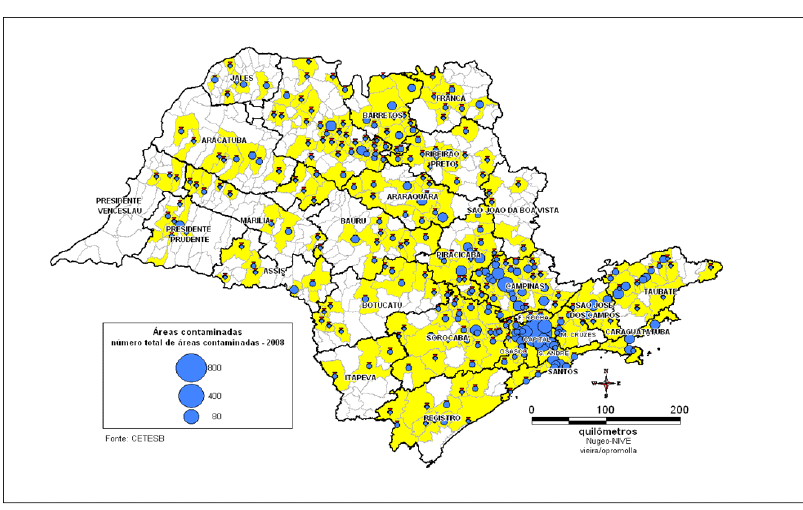
Figure 9. Contaminated areas in